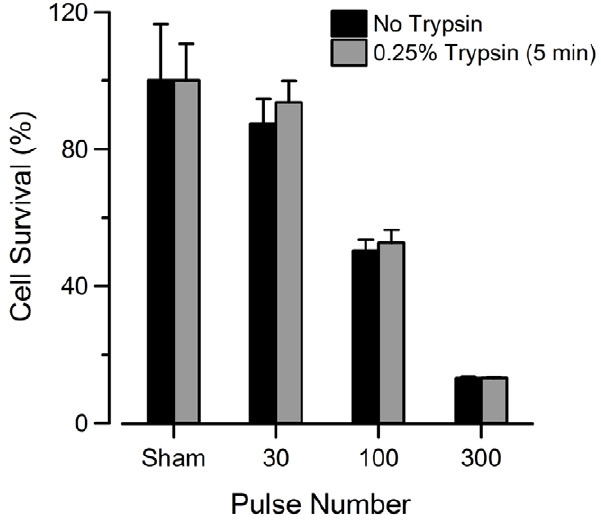
Figure 10. Trypsin treatment does not affect survival of USEP- exposed Jurkat cells. Jurkat cells were exposed to 0, 30, 100, or 300, 10-ns pulses at 60 kV/cm. MTT absorbance measurements were taken 24 hours post exposure. Trypsin treatment appears to have no effect on long-term survival of Jurkat cells. (mean + / 2 s.e, n=3).